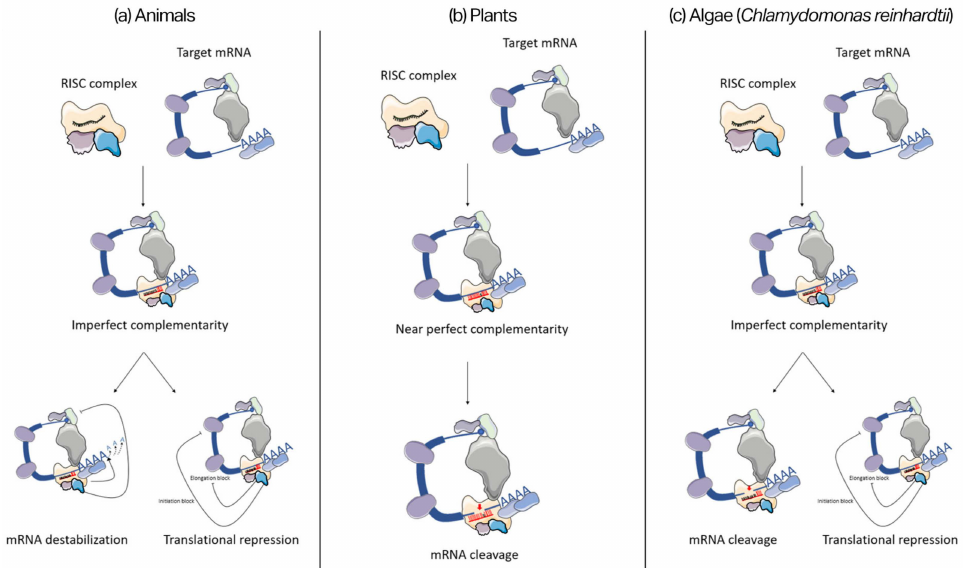
Figure 2. Schematic view of miRNA mode of action in animals, plants, and algae. For algae, the example of Chlamydomonas reinhardtii has been taken into consideration for which greater information is available on miRNA functions with respect to other algae. Regions of miRNAs colored in red are the ones that shows the perfect pairing between miRNA and mRNA, whereas the ones colored in black are those not paired. ( a ) In animals, the RISC complex is able to bind the target mRNA by an imperfect complementarity of the miRNA with its target site, pairing only the so-called “seed” region. The modes of target suppression are: the destabilization of the transcript by deadenylation of the poly(A) tail and decapping, or the translational repression by blocking translational initiation or elongation. ( b ) In plants, there is an almost-perfect complementarity between the miRNA and the target site. In addition, the mRNA cleavage is carried out by the splicing activity of the AGO protein present in the RISC complex. ( c ) In Chlamydomonas reinhardtii , there is an imperfect complementarity of the miRNA and its target site, pairing only the so-called “seed” region. The mRNA suppression can be obtained via mRNA cleavage or translational repression by blocking translational initiation or